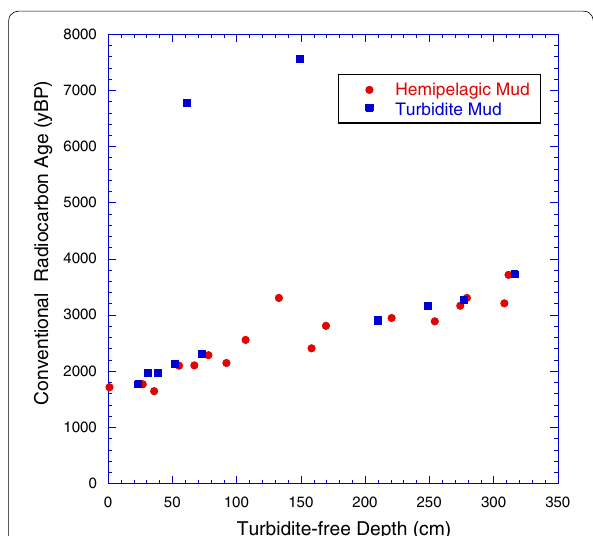
Fig. 3 Relationships between the radiocarbon ages of hemipelagic muds and turbidite-free sub-bottom depth. Ages of turbidite mud are plotted at the depths of boundaries between the overlying and underlying hemipelagic